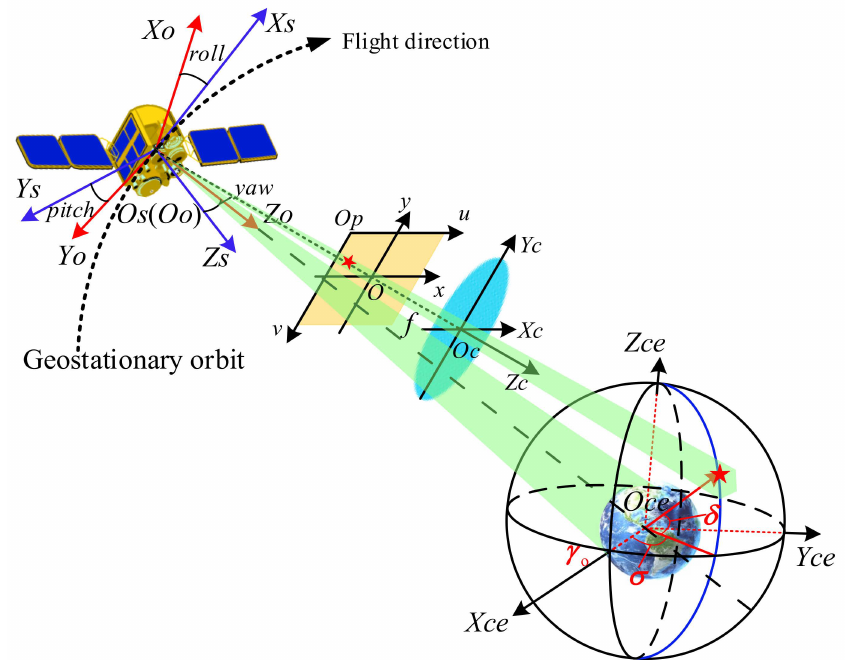
Figure 1. Diagram of the geometric positioning model of the geostationary RSC. Op-u-v , O-x-y , Oc-XcYcZc , Os-XsYsZs , Oo-XoYoZo and Oce-XceYceZce are the pixel coordinate system, the image coordinate system, the camera coordinate system, the satellite body coordinate system, the orbital coordinate system, and the celestial coordinate system, respectively. x-axis and y-axis are parallel to u-axis and v-axis respectively. Xc -axis and Yc -axis are parallel to x-axis and y-axis, respectively. Os and Oo is located in the centroid of the satellite. Xs points in the flight direction of the satellite, Ys is along the horizontal axis of the satellite, and Zs is determined by the right-hand rule. Xo points in the direction of satellite motion, Zo points to the center of the earth, and Yo is determined according to the right-hand rule. Xce points the vernal equinox γ 0 , Yce is perpendicular to Xce in the equatorial plane, and Zce is perpendicular to the equatorial plane and points to the celestial pole.